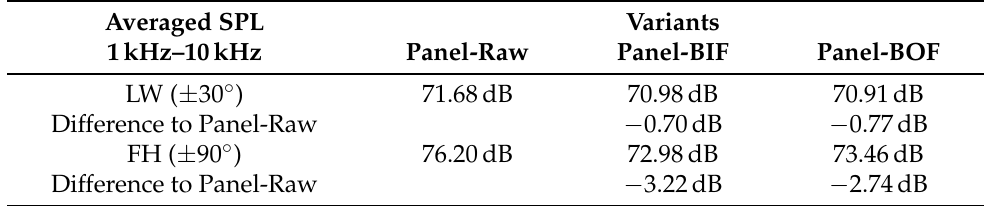
Table 3. Averaged SPL in the LW compared to the FH in the frequency range of 1kHz to 10kHz. Averaged